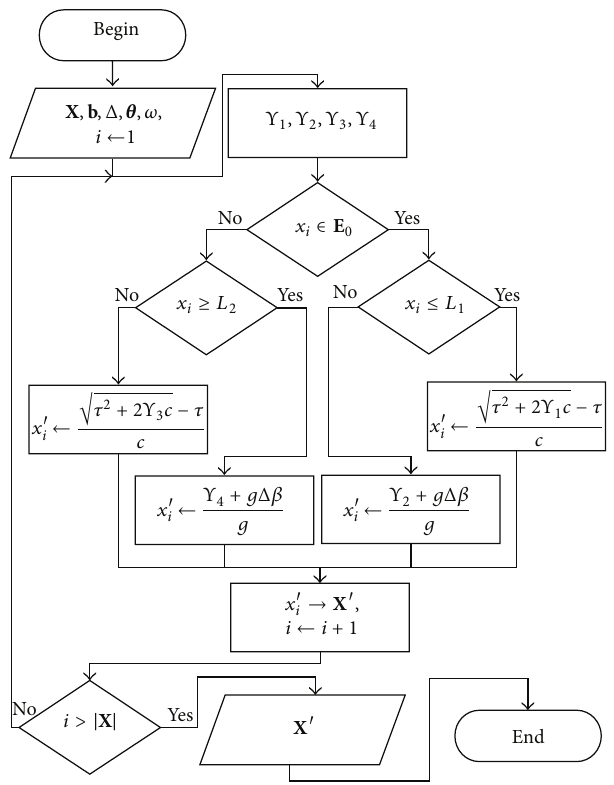
Figure 5: Quantization diagram for the 𝑘 th embedding interval.